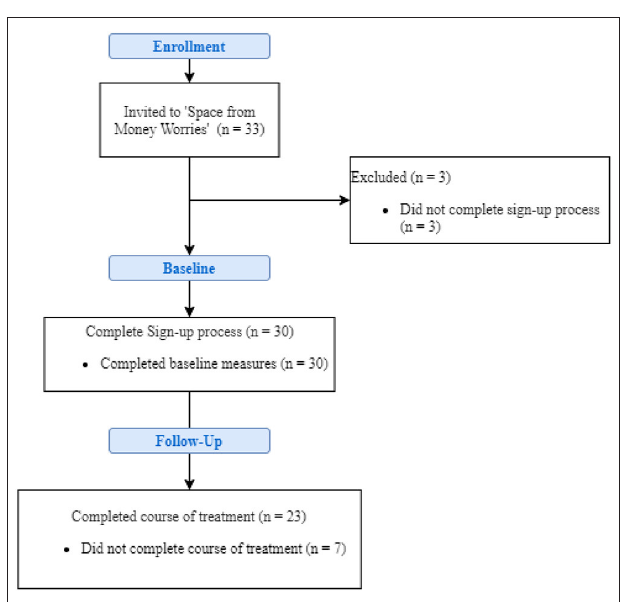
FIGURE 4 | Flowchart of the